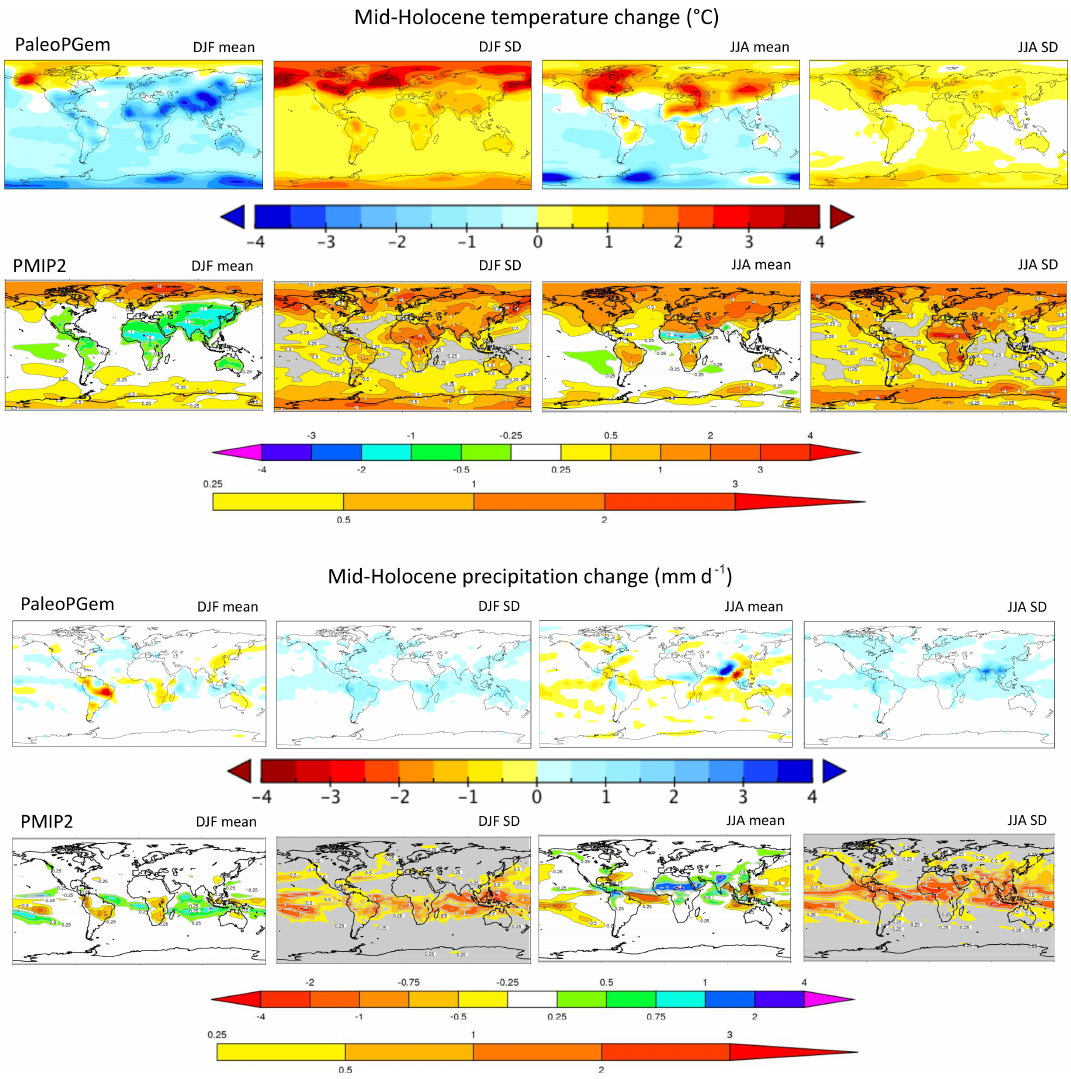
Figure 3. PALEO-PGEM emulated ensemble comparison with PMIP2 ocean–atmosphere–vegetation ensemble (Braconnot et al., 2007) for the